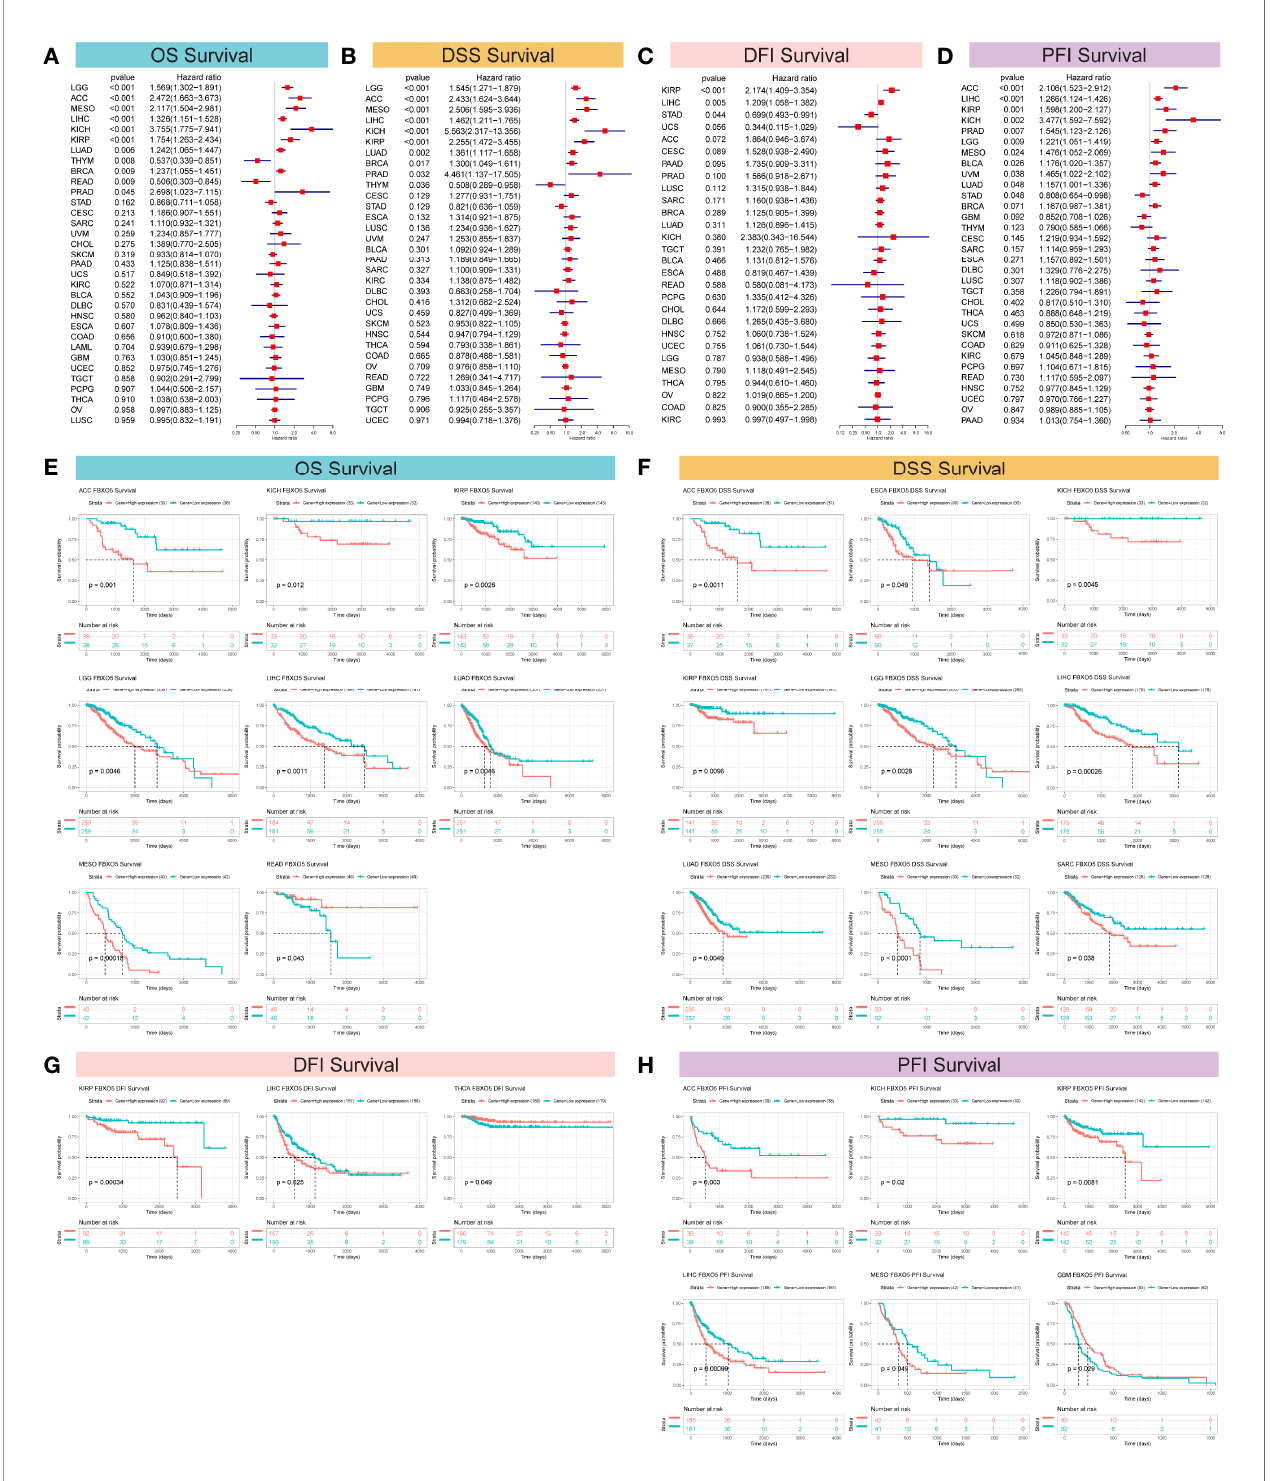
FIGURE 4 | Correlation of FBXO5 expression with survival prognosis in the distinct malignancies studied. (A – D) Forest plots revealing the associations of FBXO5 with OS (A) , DSS (B) , DFI (C) , and PFI (D) in the indicated tumors, respectively. (E – H) Kaplan-Meier curves showing the relationships of FBXO5 expression with OS (E) , DSS (F) , DFI (G) , and PFI (H) in the indicated cancers,